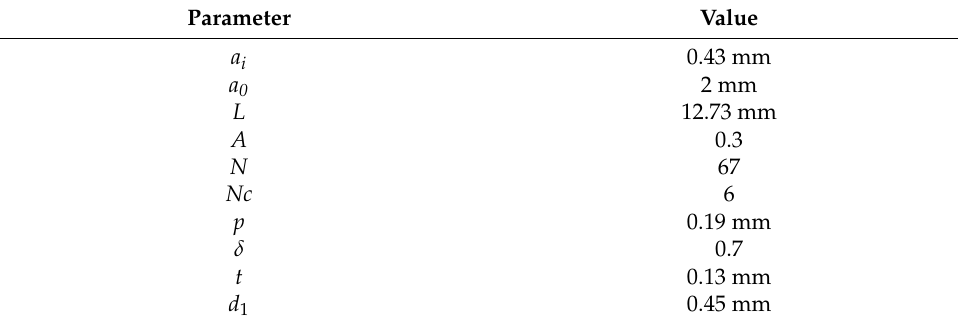
Table 1. Parameters of TE 11 -HE 11 corrugated mode